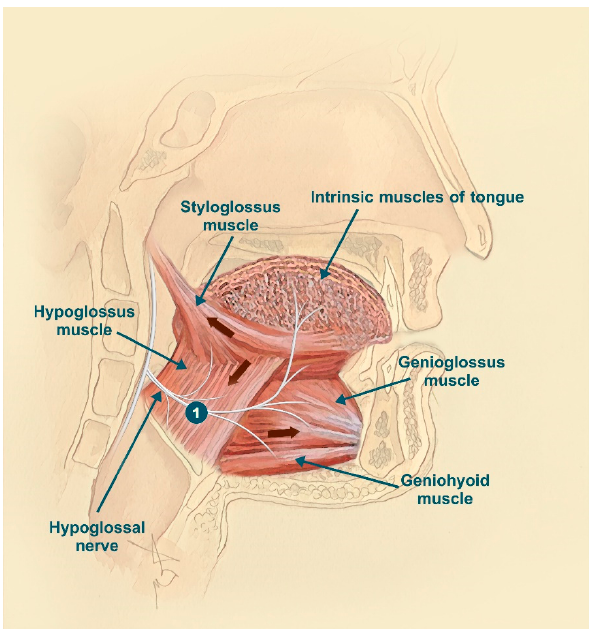
Figure 3. Hypoglossal nerve: course and branches. The genioglossus (GG) muscle is innervated by the medial branch of the hypoglossal nerve, increasing muscle activity during inspiration and reducing it during expiration. 1: correct position for electrical nerve stimulation.